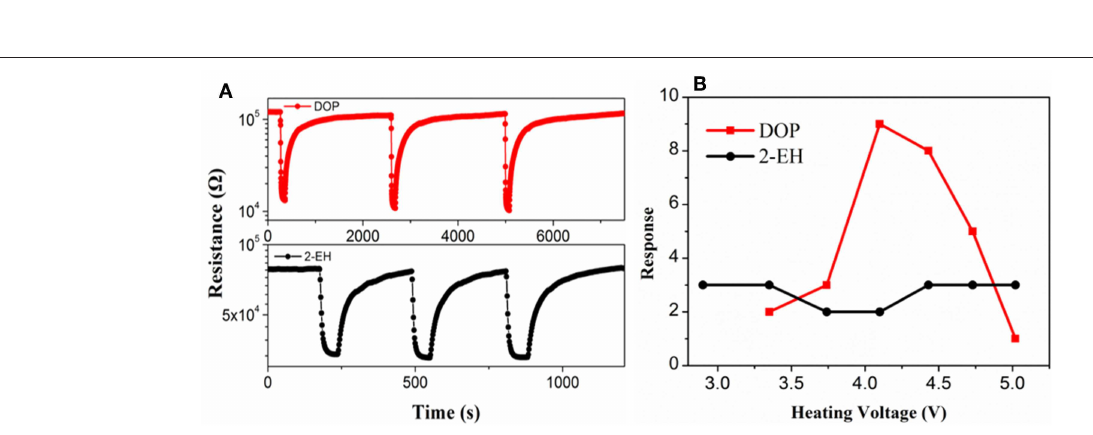
FIGURE 3 | Calibrated concentration of (A) DOP and (B) 2-EH at different cable temperatures.